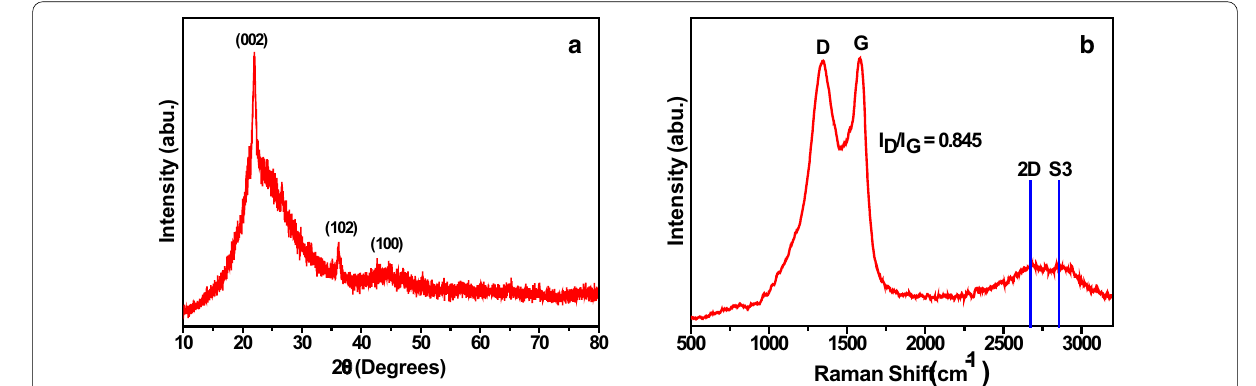
Fig. 2 a XRD pattern and b Raman spectrum of as-synthesized activated